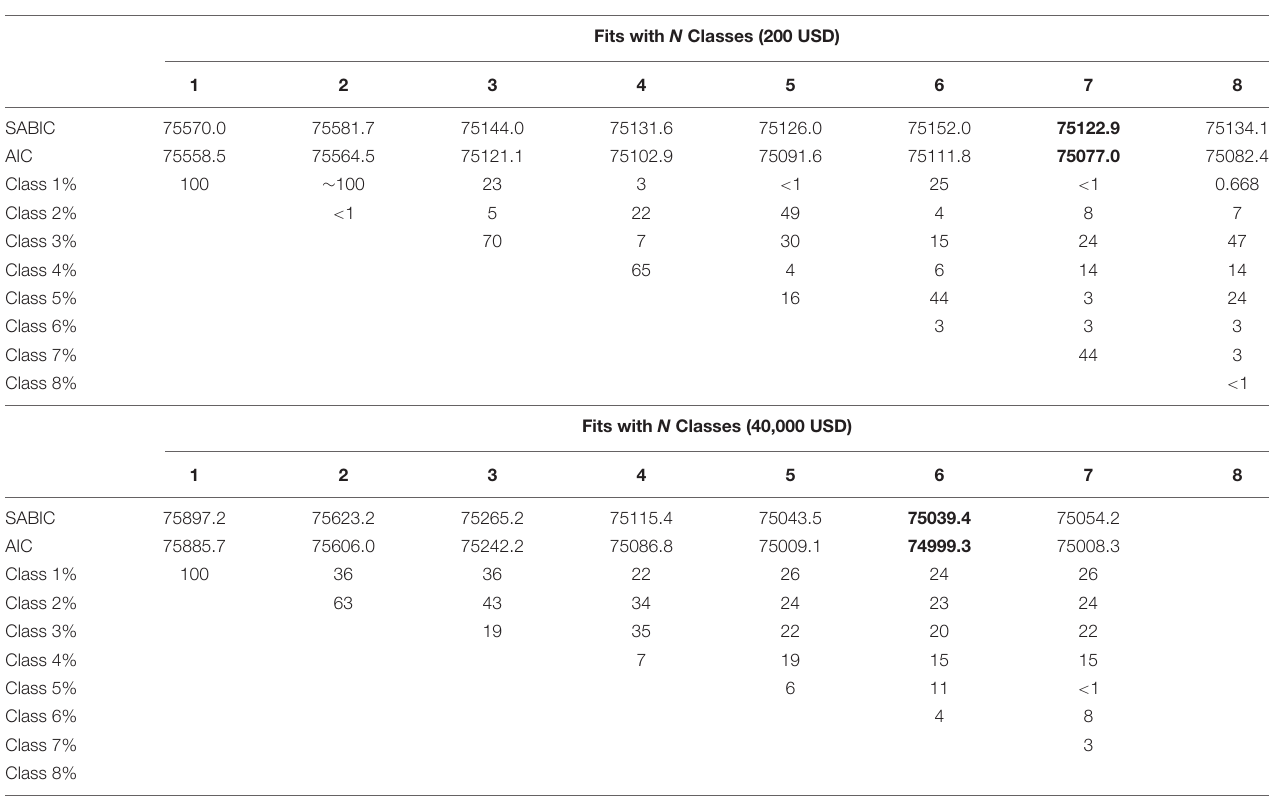
TABLE 2 | Evaluation of latest classes across discounting tasks.